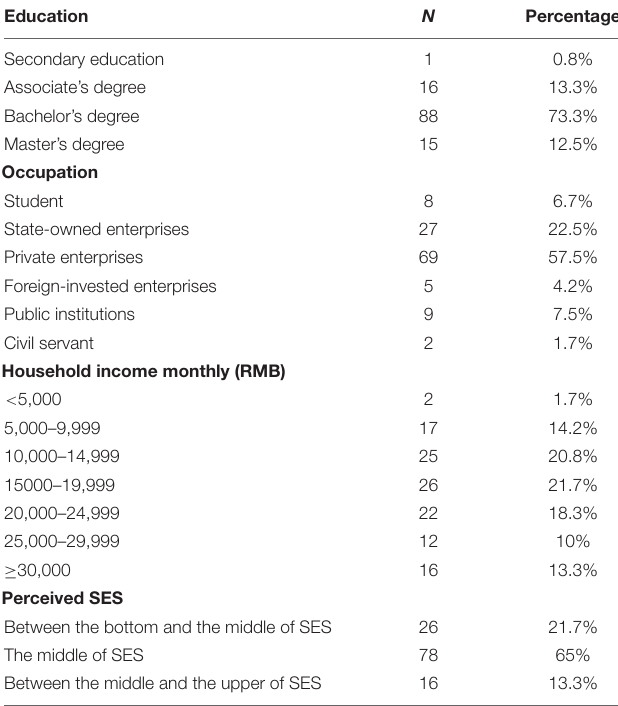
TABLE 4 | Description of participants demographics in Study